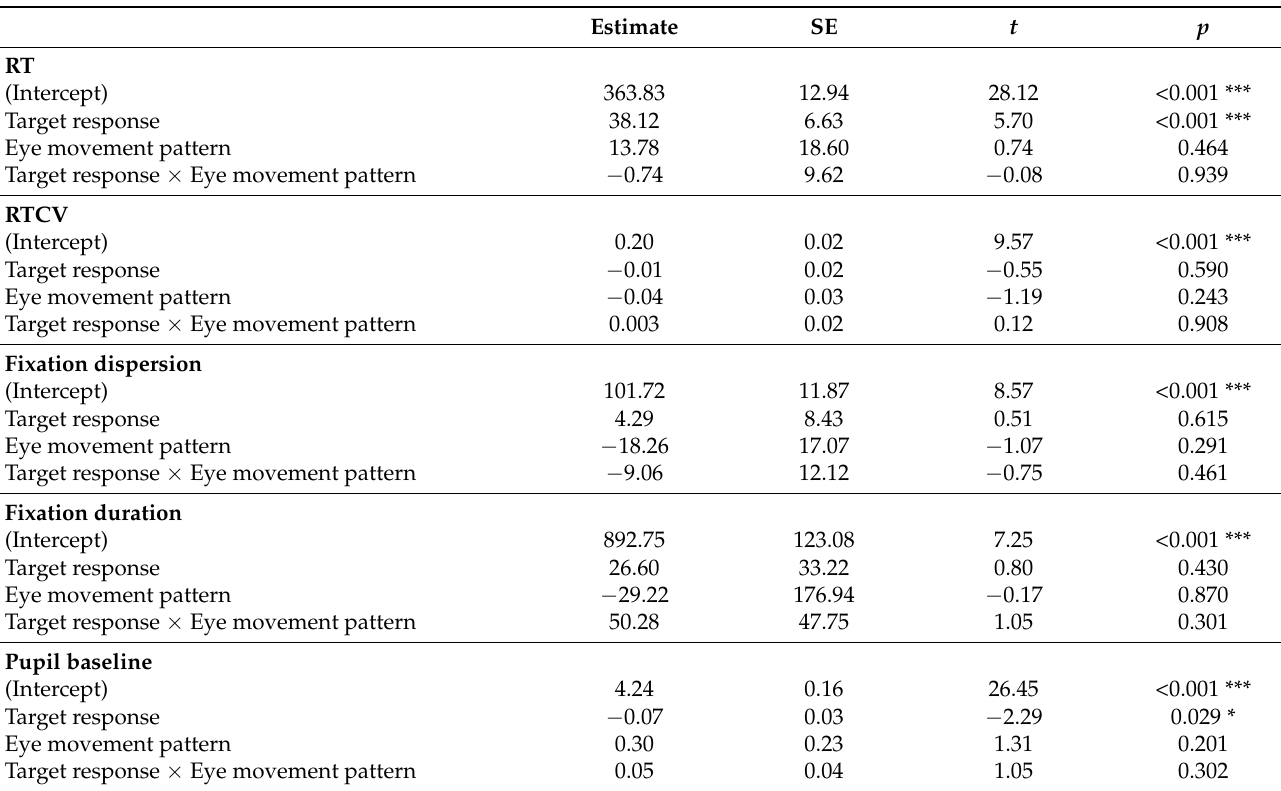
Table 1. Behavioral response data and eye movement data for the 10-s pre-target period (the objective measurement of MW) analyzed with